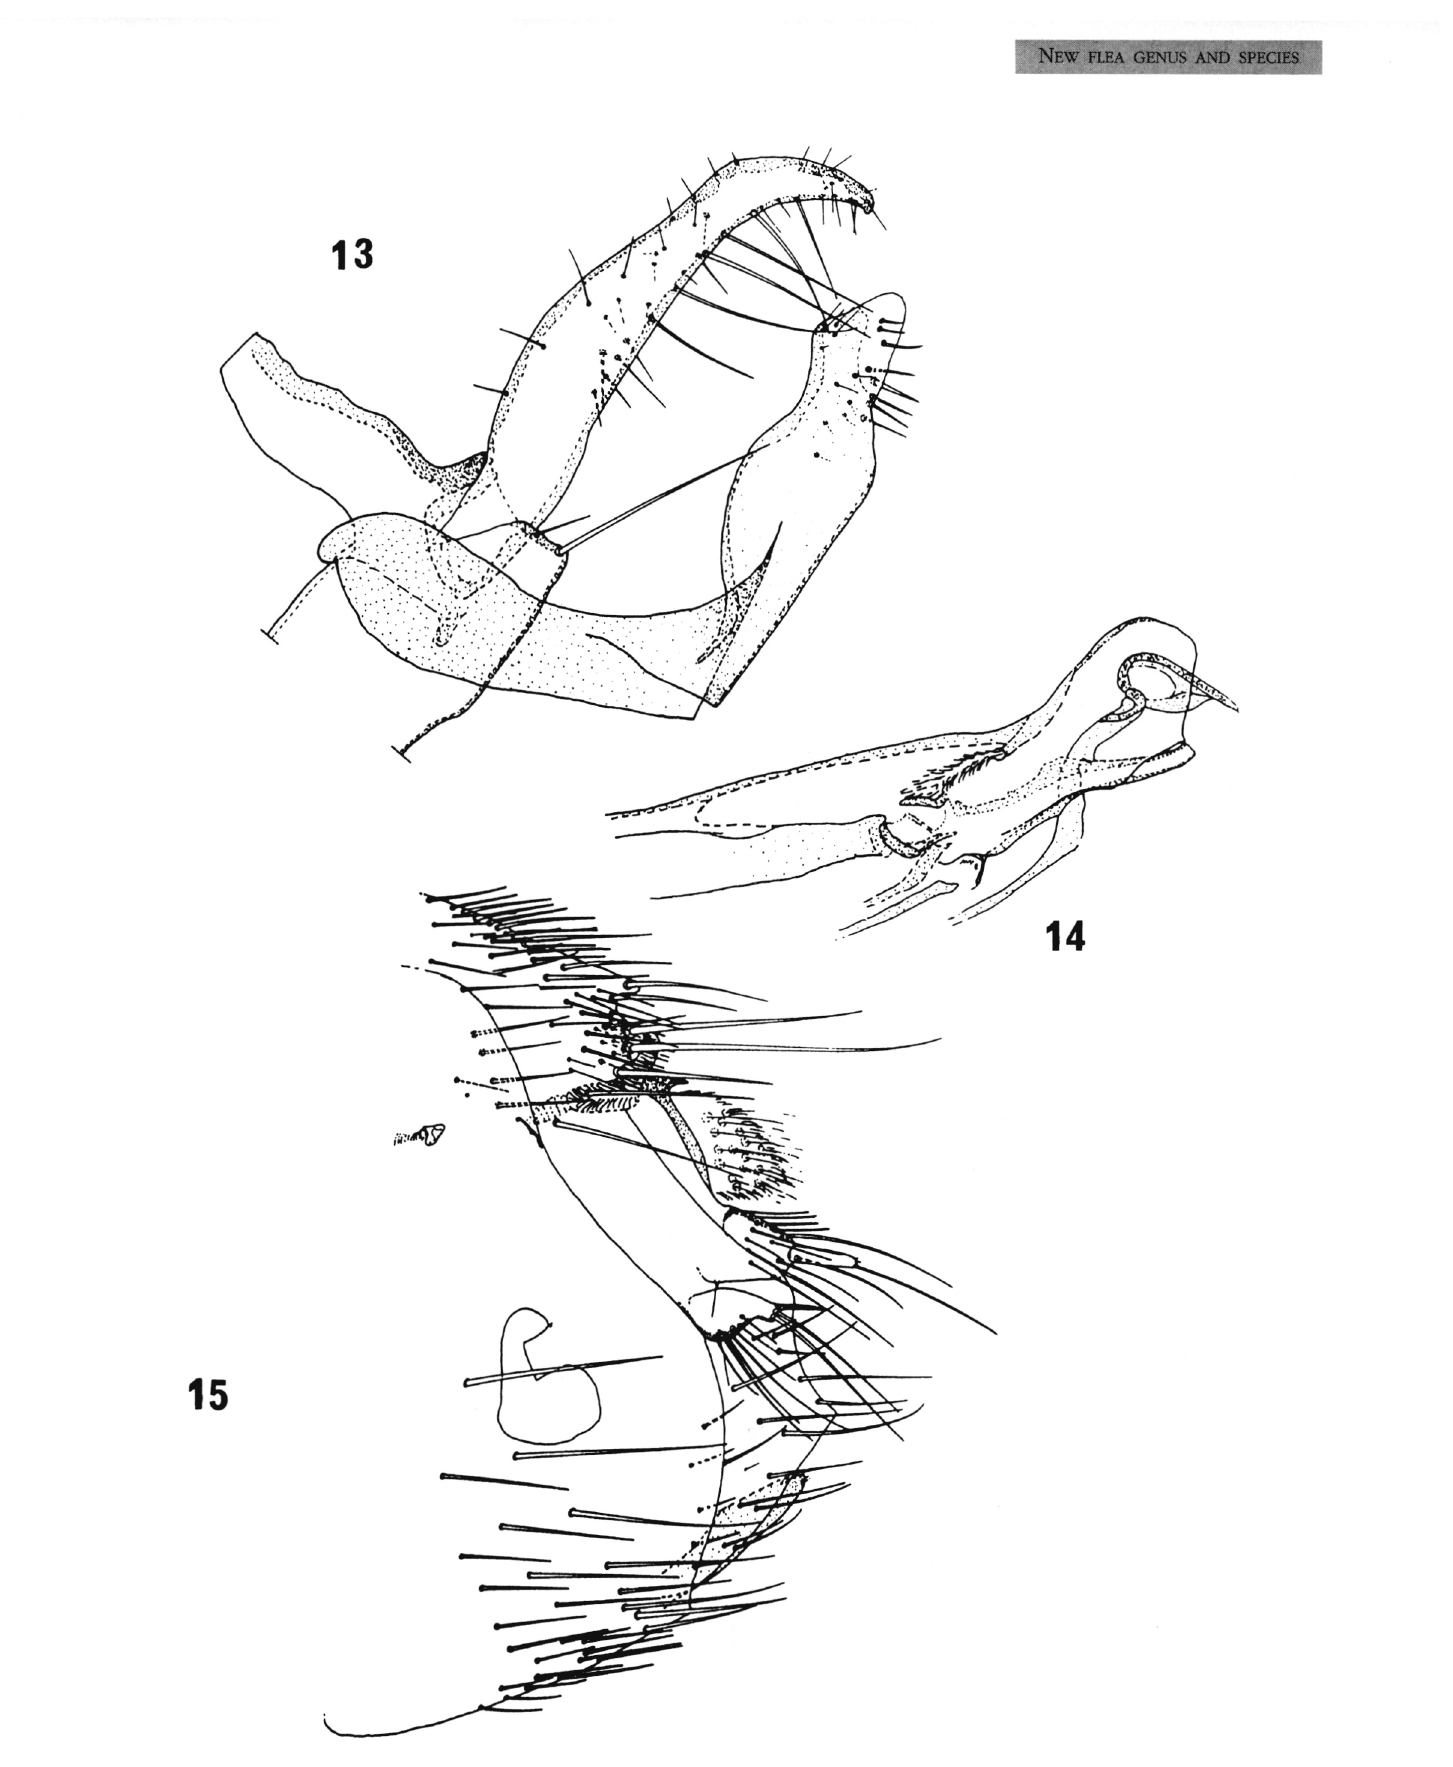
Figs 13-15. - Gymnomeropsylla margaretamydis Durden & Beaucournu, n. gen., n. sp. 13: segment IX (tergite, holotype male; sternite, paratype male); 14: phallosome (paratype male); 15: segments VII, VIII and IX (composite drawing from allotype and paratype